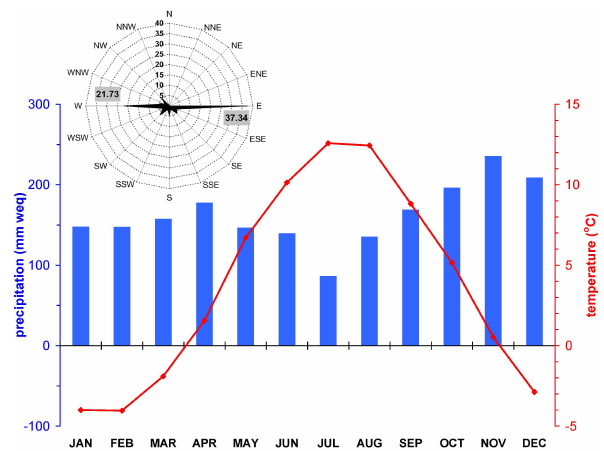
Fig. 3. Climate variables at Zavižan. Monthly mean temperature (red) and precipitation totals (blue, in water equivalents) for the 1958–2009 period. Inset figure: long-term average distribution of wind directions. Percentage values for the prevailing easterly and westerly wind directions are